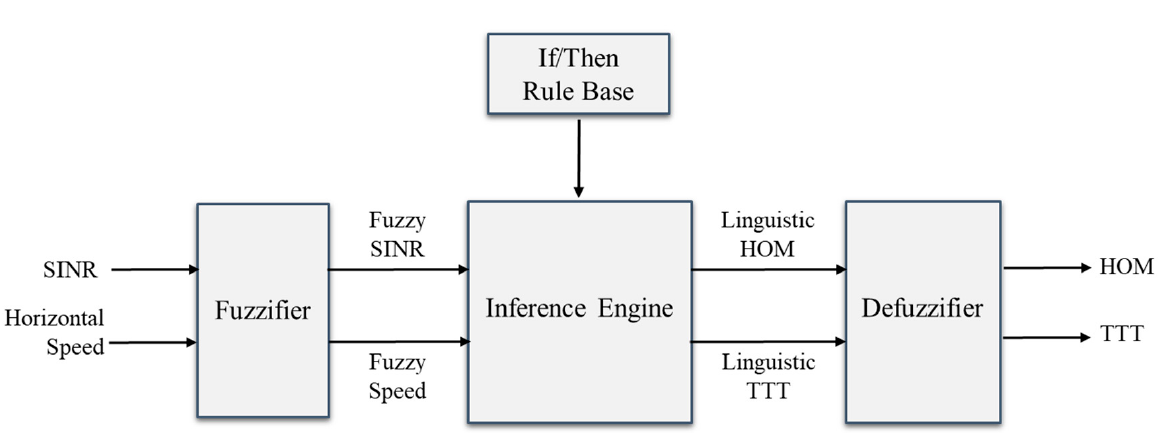
Figure 4. Illustration of the horizontal moving speed of UE.